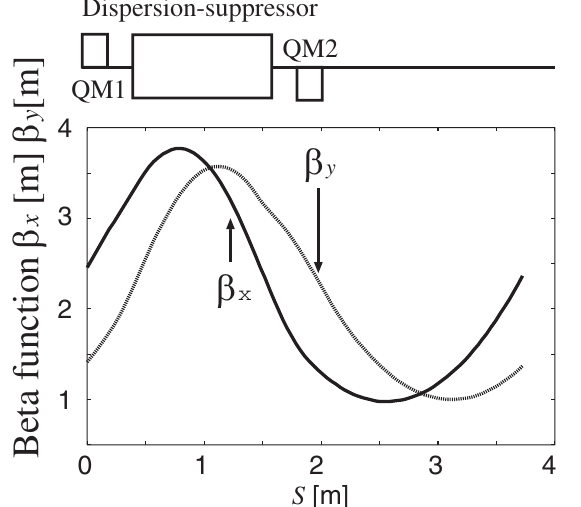
(cid:5) (cid:3) ; k FIG. 3. Beta functions at the operating point (cid:4) k 1 2 (cid:5) (cid:3) (cid:4) 2 : 072 ; 2 : 072 (cid:5) . The beta (cid:4) 0 : 78 (cid:9) m (cid:1) 2 (cid:10) ; (cid:1) 1 : 24 (cid:9) m (cid:1) 2 (cid:10)(cid:5) , (cid:4) (cid:5) ; (cid:5) x y functions are drawn as a function of the position s . FIG. 4. Cross section around the electrostatic deflector of S- LSR. The height of the electrostatic deflector is limited by the gap size of the dipole magnet and the vacuum vessel. The electrostatic deflector is constructed with a pair of main elec- trodes and four pairs of intermediate electrodes. The voltage applied to the intermediate electrodes strongly dominates the electric field distribution in the electrostatic deflector. Therefore, various field distributions can be realized approximately by changing the applied voltage to the intermediate